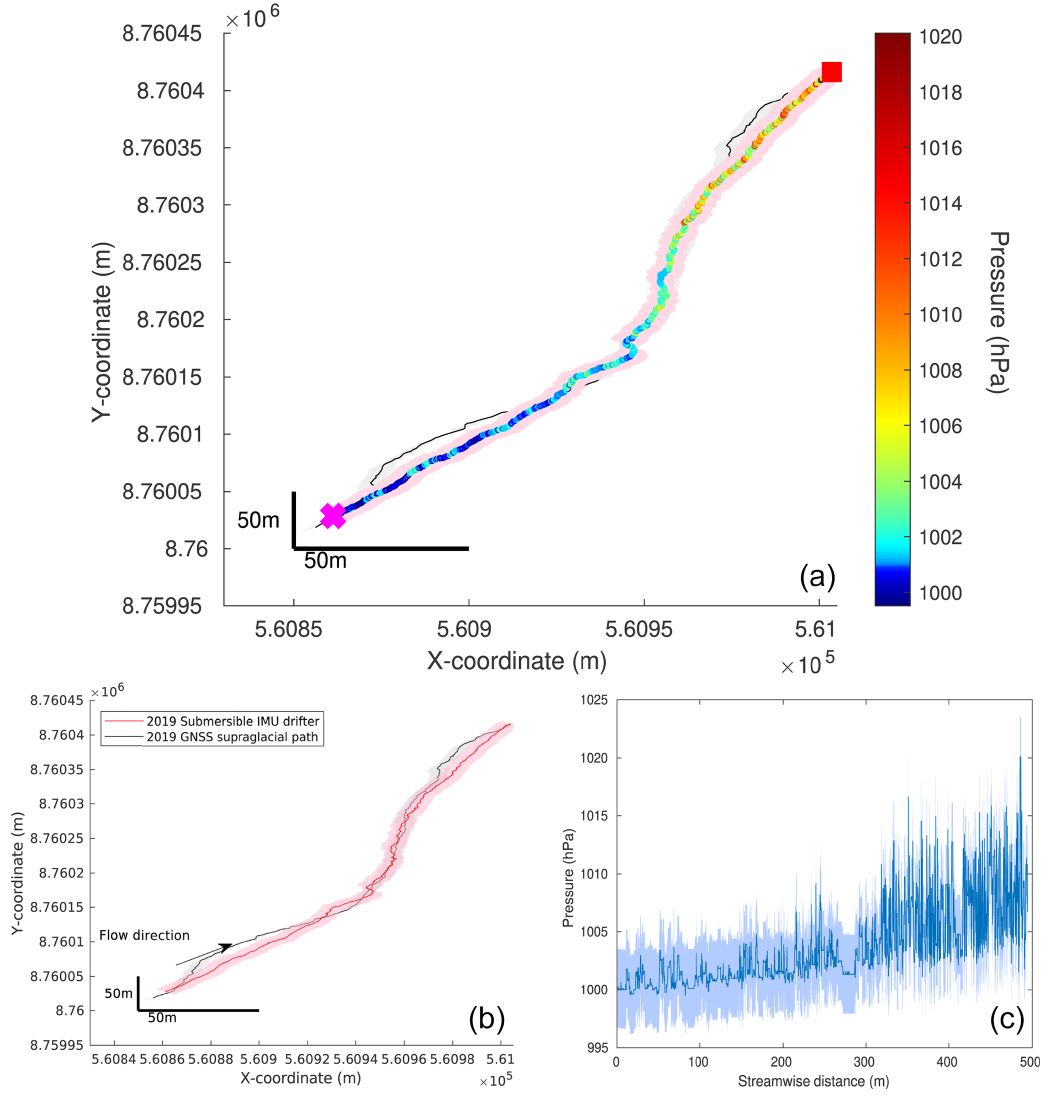
Figure 5. Supraglacial-water flow path reconstruction. (a) Reconstructed supraglacial track in UTM coordinates with pressure distribution in hectopascals. The deployment is marked with a pink cross, and the recovery is a red square. (b) Estimation of the supraglacial track (red) with standard deviations (pink) in UTM coordinates. The GNSS reference is shown in black, and the average error of the GNSS recordings is in light gray. (c) Average water pressure with standard deviation along the estimated streamwise distance of the supraglacial channel.